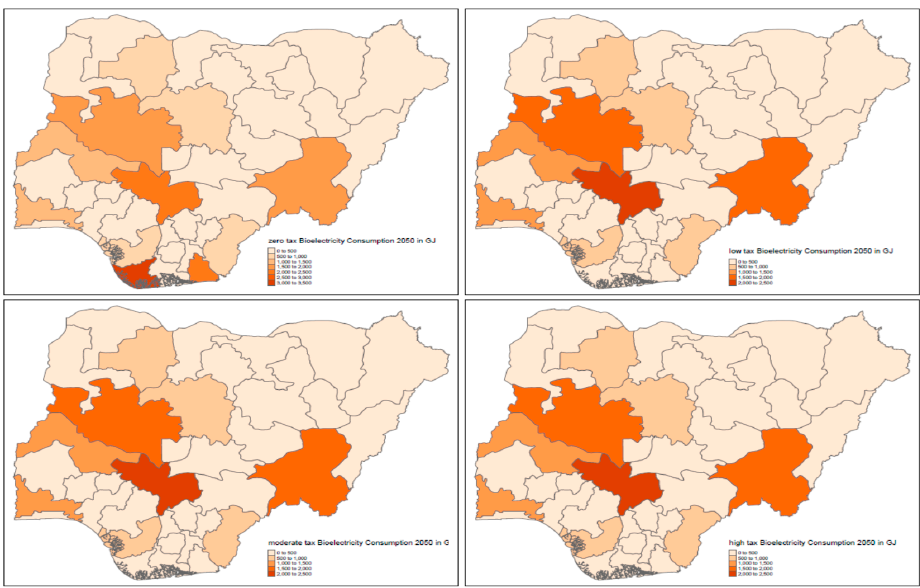
Figure 13. Bioelectricity consumption by 2050 under no subsidy action.